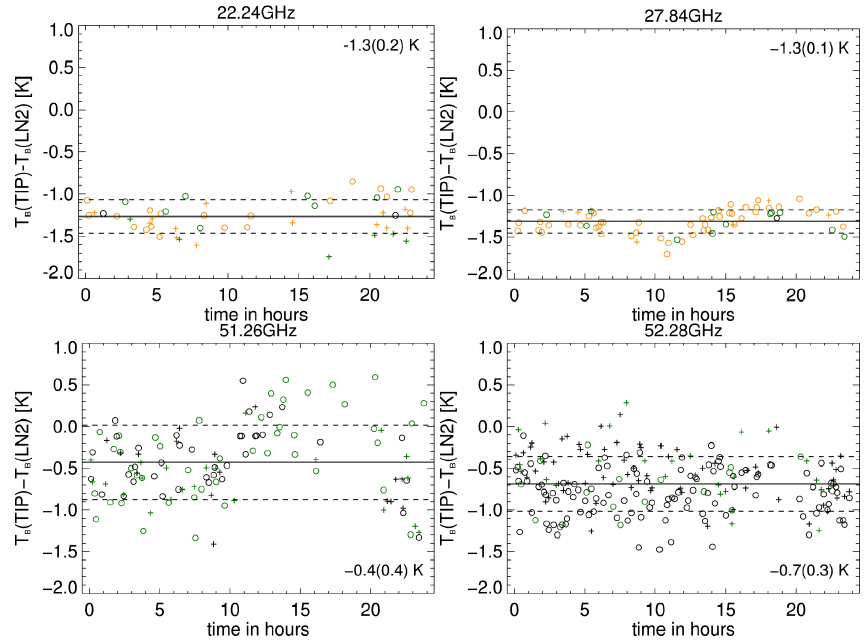
Fig. 10. Time series of tipping curve results T b (TIP) (16 August 2009) minus the original LN 2 calibration T b (LN 2 ) (11 August 2009) for selected HATPRO-G2 channels. The daily mean value (standard deviation) is displayed within each subfigure. Crosses: one-sided elevation scans towards 70 ◦ N, circles: scans towards 250 ◦ N, black lines: mean calibrated zenith T b and standard deviation (dashed) for scans towards 250 ◦ N; quality control thresholds are set to corr min =0.9995, χ 2 max =1.0 × 10 − 4